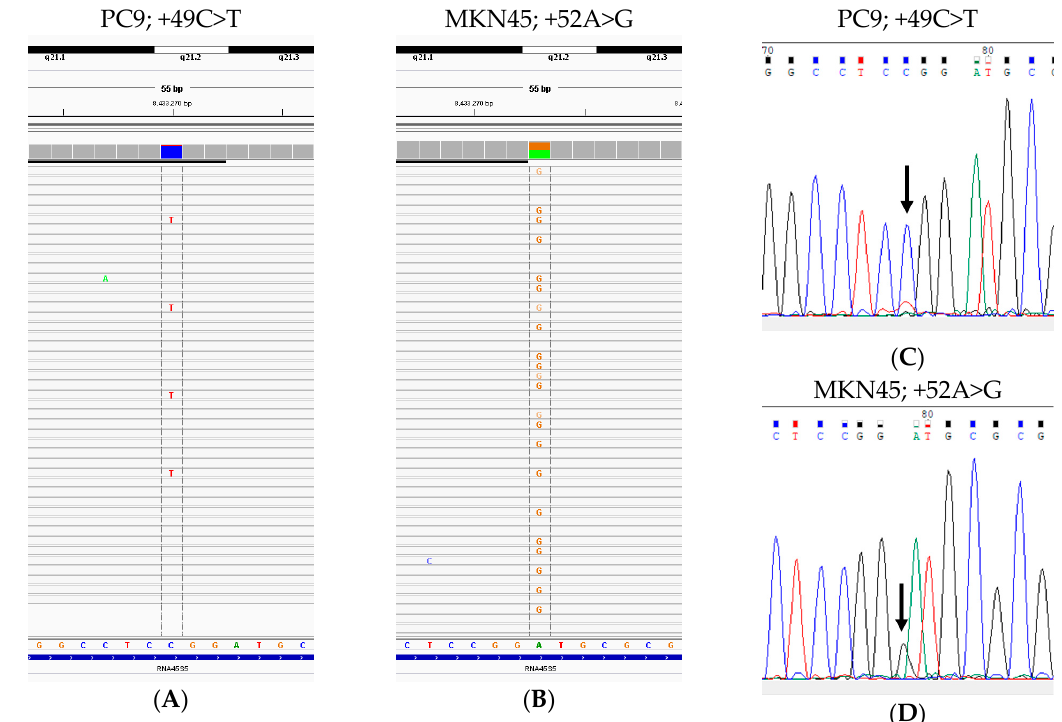
Figure 2. Representative single-nucleotide variations (SNVs) observed in cell lines. ( A ) PC9; +49C>T (variant allele frequency (VAF]): 8%) and ( B ) MKN45; +52A>G (VAF: 47%) detected by next-generation sequencing. ( C , D ) Sanger electropherograms depicting SNVs PC9, +49C>T ( C ) and MKN45, +52A>G ( D ).